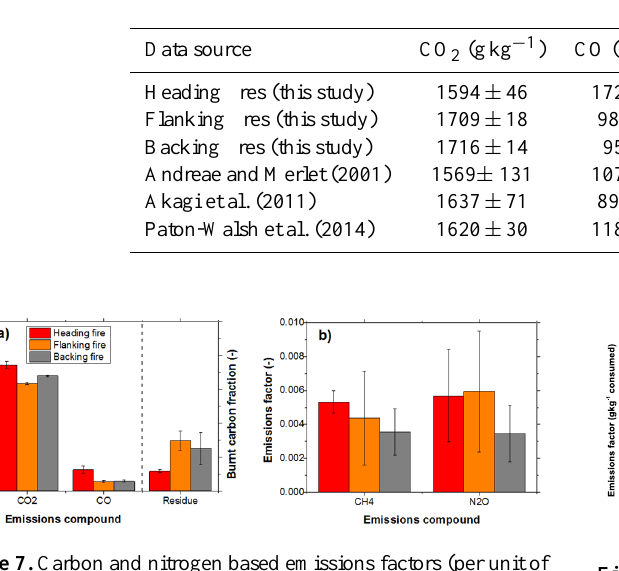
Figure 8. Carbon and nitrogen based emissions factors (per unit of dry fuel consumed) for different combustion phases within the experimental burns: (a) CO 2 and CO emissions factors for flaming and smouldering combustion; (b) CH 4 and N 2 O emissions factors for flaming and smouldering